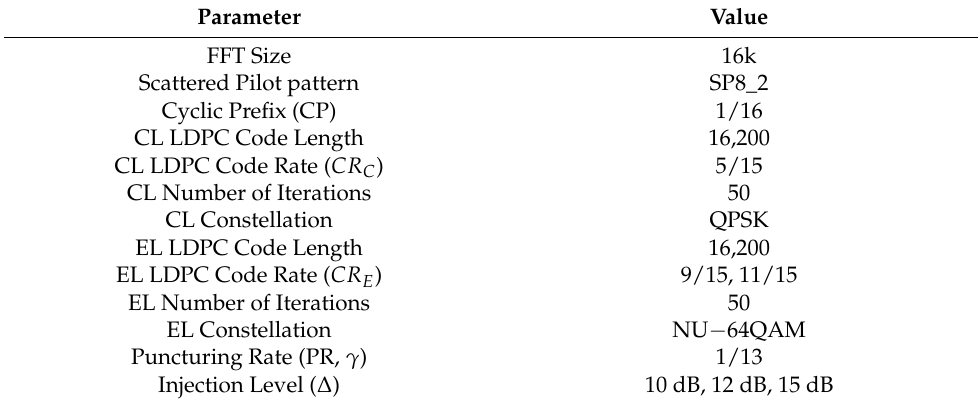
Table 2. Simulation